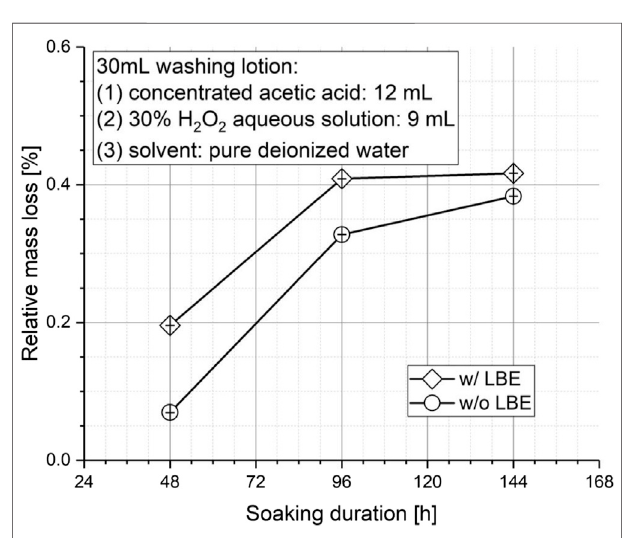
FIGURE 7 | In fl uence of soaking duration on the corrosion mass loss rate of austenitic stainless steel.